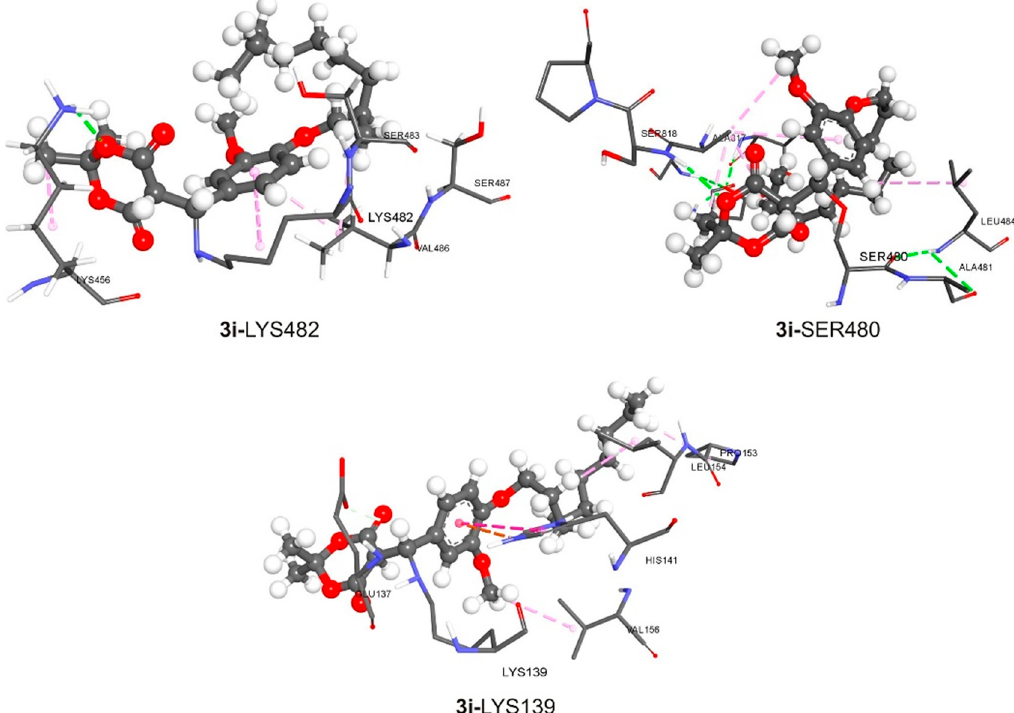
Figure 5. The docking interactions of the most stable conformation of 3i and investigated receptors.